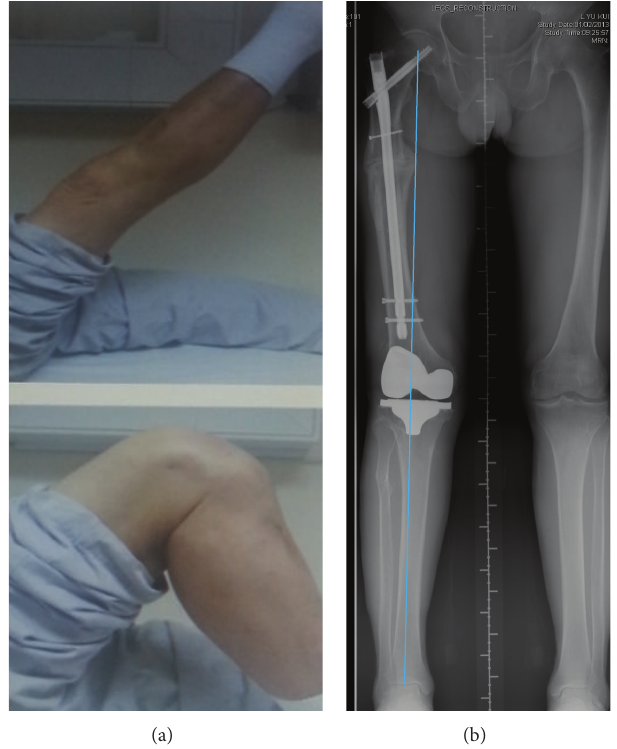
Figure 2: (a) Clinical photos showing active right knee range of motion. (b) Standing scanogram of both lower limbs showing satisfactory right lower limb mechanical axis and equal limb